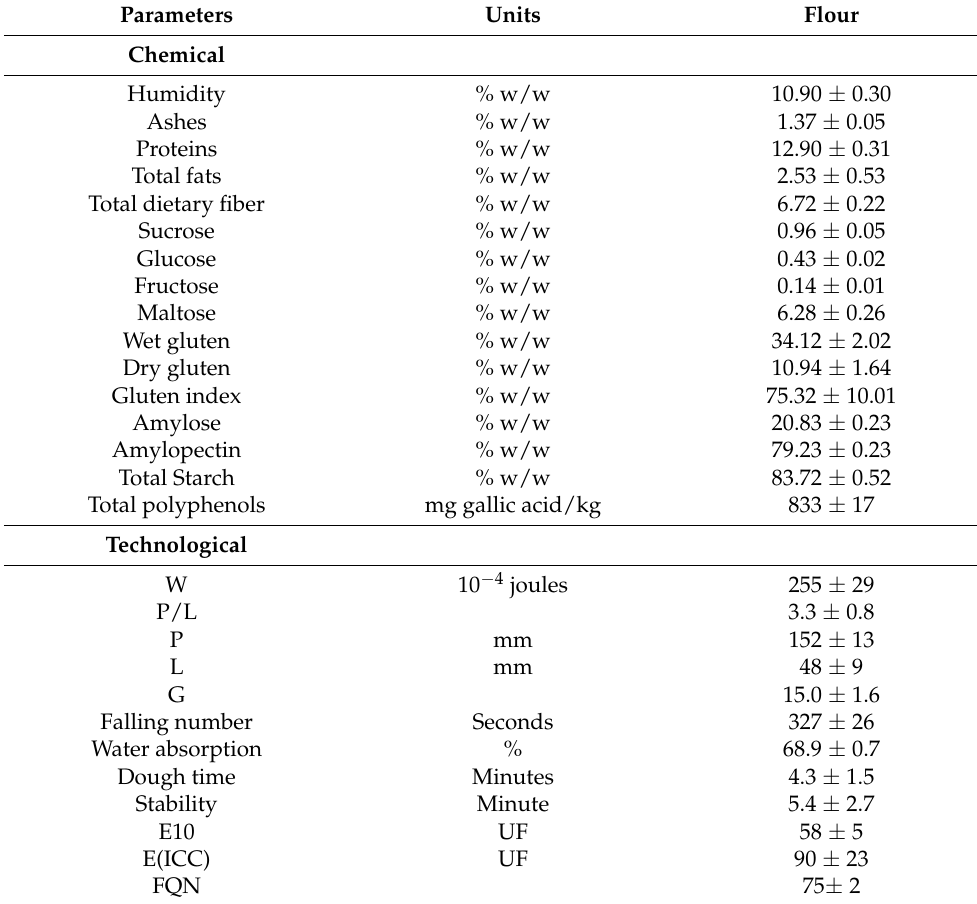
Table 1. Chemical composition and technological features of flour. Results are expressed as mean ± SD (n =